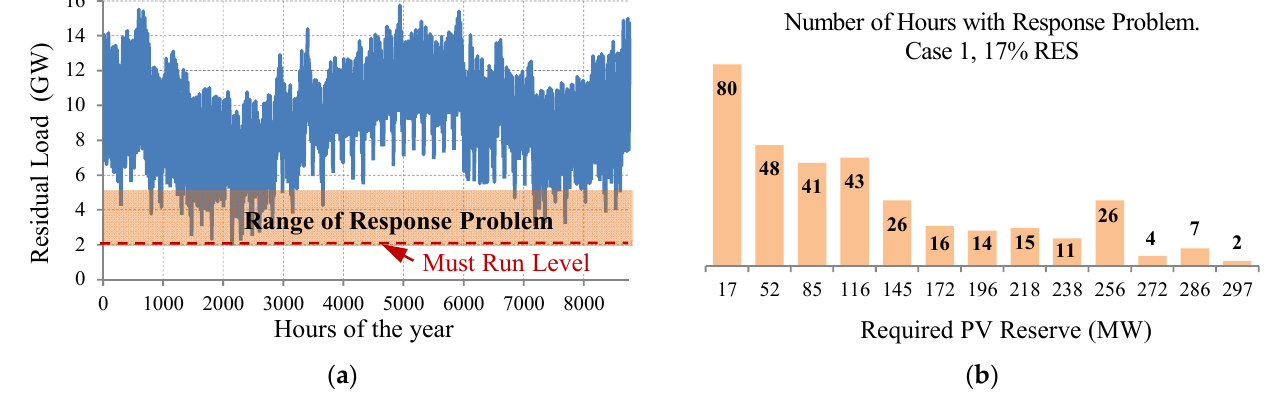
Figure 11. ( a ) Residual Load through the year 2030; ( b ) distribution of necessary PV Reserve in the Range of the Response Problem, Case 1.